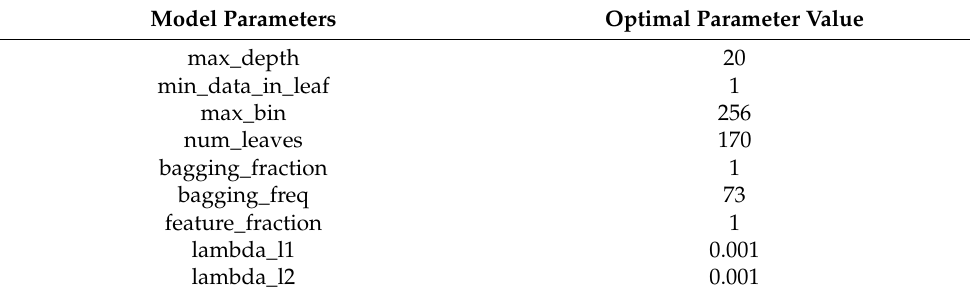
Table 5. Parameter optimization results.